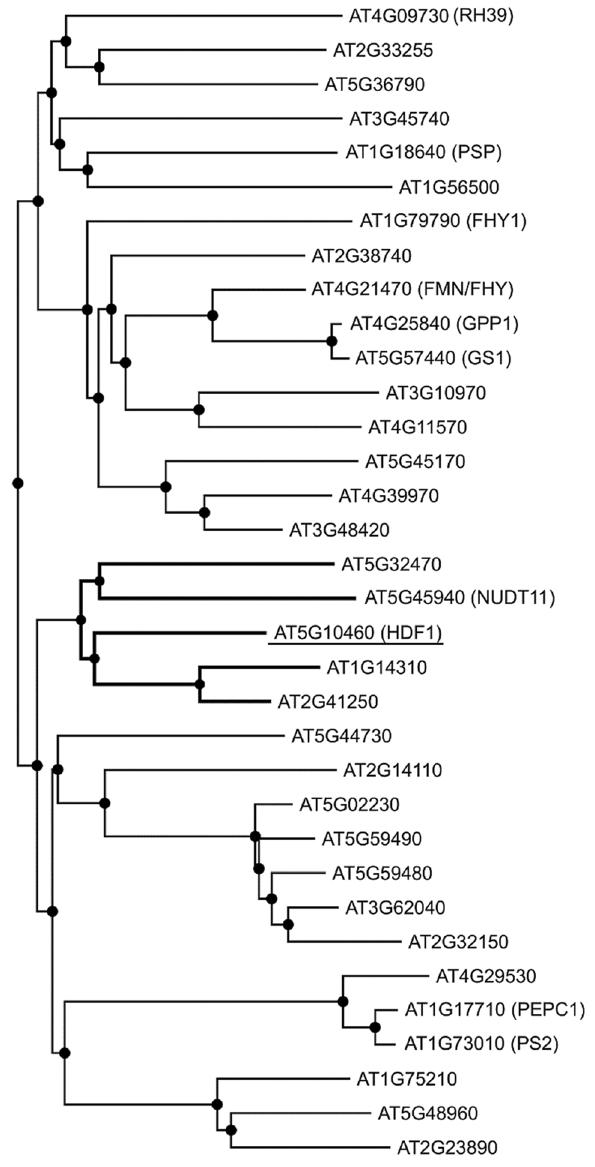
Figure 3. Phylogenetic analysis of HDF1 . Phylogenetic tree of HAD superfamily proteins from Arabidopsis neighboring HDF1. Alignment of the predicted sequences was made using MAFFT version 7. The phylogenetic tree was constructed using the PHYML 3.0 web server. The complete tree can be seen in Suppl. Fig.